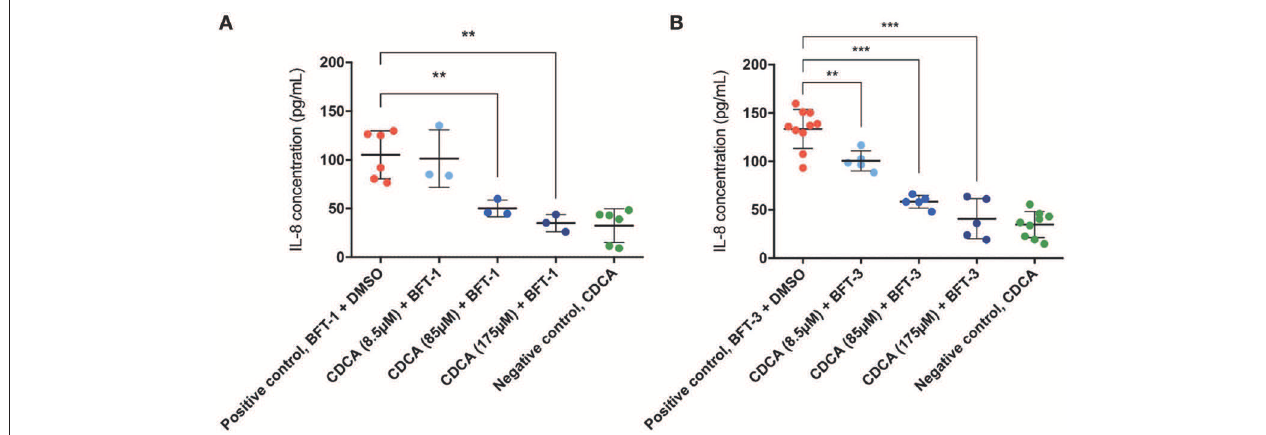
FIGURE 6 | CDCA inhibits IL-8 secretion induced by BFT-1 and BFT-3. The amount of IL8 secreted by HT29/c1 cells for 4h was measured by an IL-8 ELISA. CDCA in increasing concentrations shows significant inhibition of BFT-1 (A) and BFT-3 (B) . In experiments with BFT-1, CDCA results in a significant mean 52% (unpaired t -test, P = 0.0080) and 67% (unpaired t -test, P = 0.0023) reduction of IL-8 at 85 and 175 µ M, respectively (A) . For BFT-3, CDCA significantly reduced IL-8 concentrations with a mean 24% (unpaired t -test, P = 0.0049), 56% (unpaired t -test, P < 0.0001) and 69% (unpaired t -test, P < 0.0001) at 8.5, 85, and 175 µ M, respectively (B) . BFT-1, N = 3–6 and BFT-3, N = 5–10. Bars indicate means and standard deviations. (unpaired t -test, ** P = 0.001–0.01; *** P < 0.001).